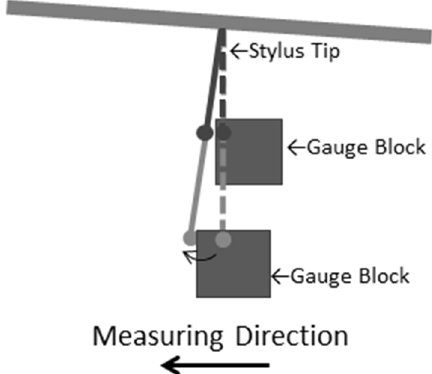
Figure 6. Avoiding the elastic deformation of stem bending which creates an undesirable triggering behavior.